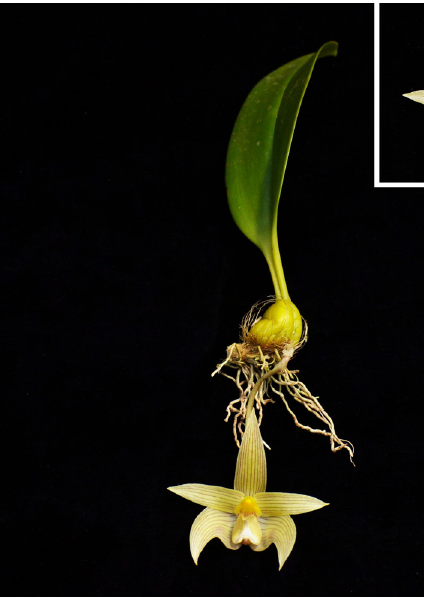
Image 1. Bulbophyllum affine Wall. ex Lindl. Image 2. Bulbophyllum lobbii